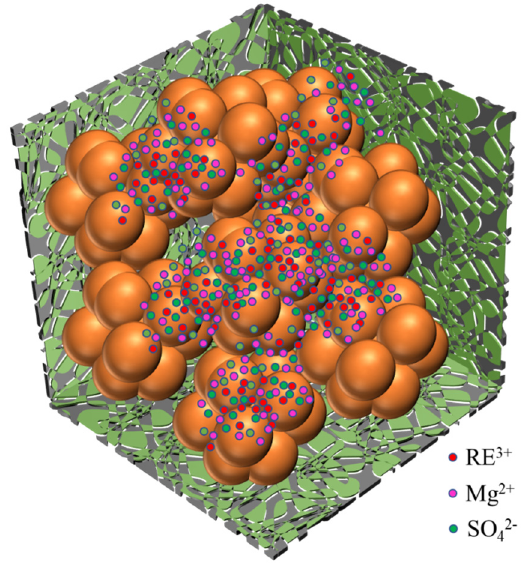
Figure 8. Particle reaction bed